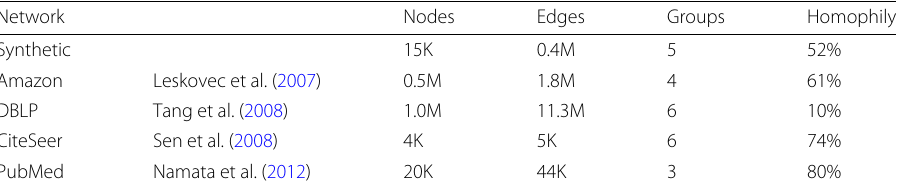
Table 2 Networks and the number of metada groups used in experiments Network Nodes Edges Groups Homophily Synthetic 15K 0.4M 5 52% Amazon Leskovec et al. (2007) 0.5M 1.8M 4 61% DBLP Tang et al. (2008) 1.0M 11.3M 6 10% CiteSeer Sen et al. (2008) 4K 5K 6 74% PubMed Namata et al. (2012) 20K 44K 3